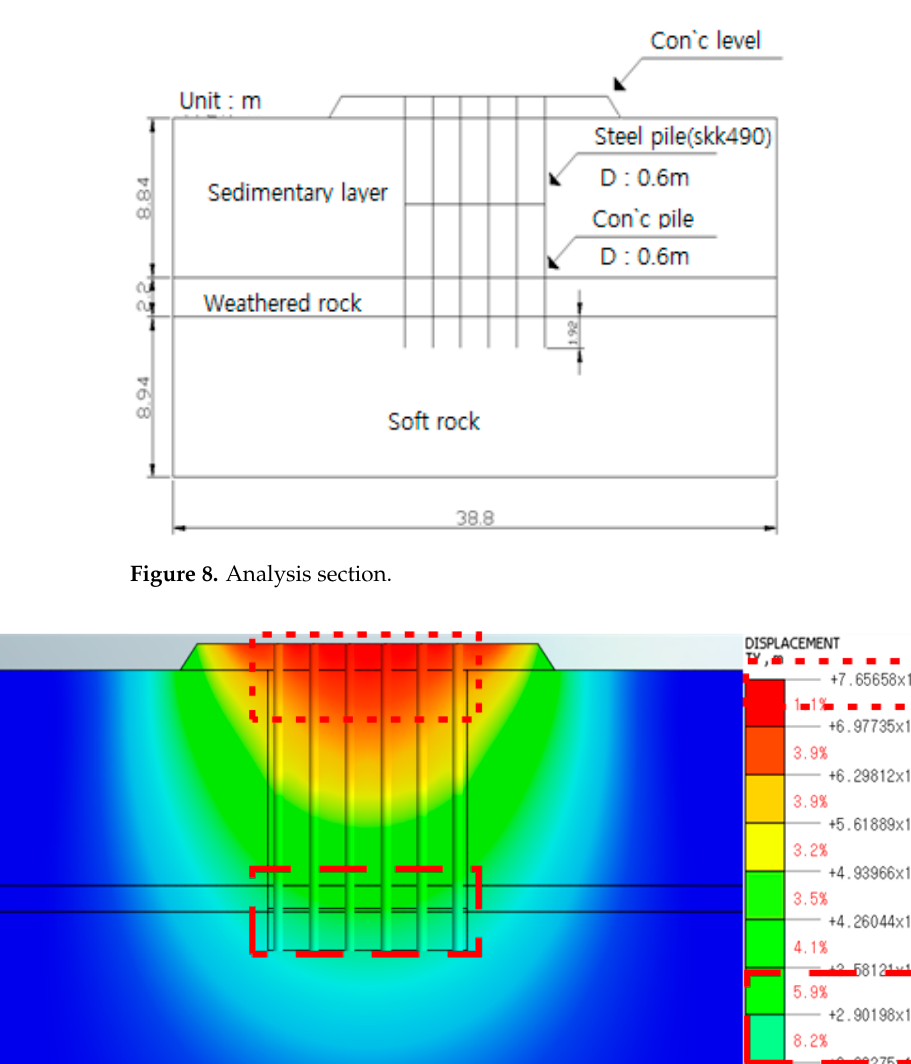
Table 11. Numerical analysis results.